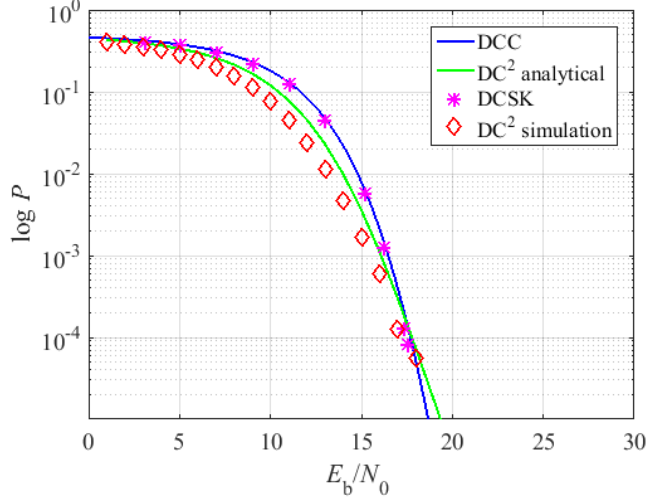
Figure 13. Comparison of bit error ratio among different communication schemes for K = 100.